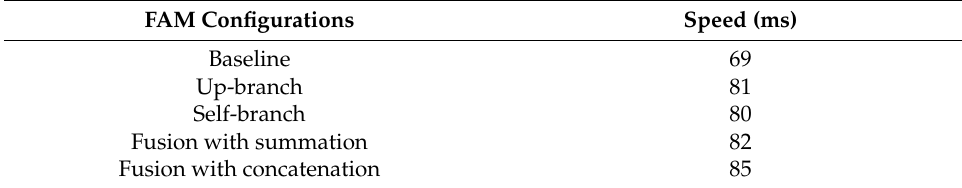
Table 3. Achieved inference